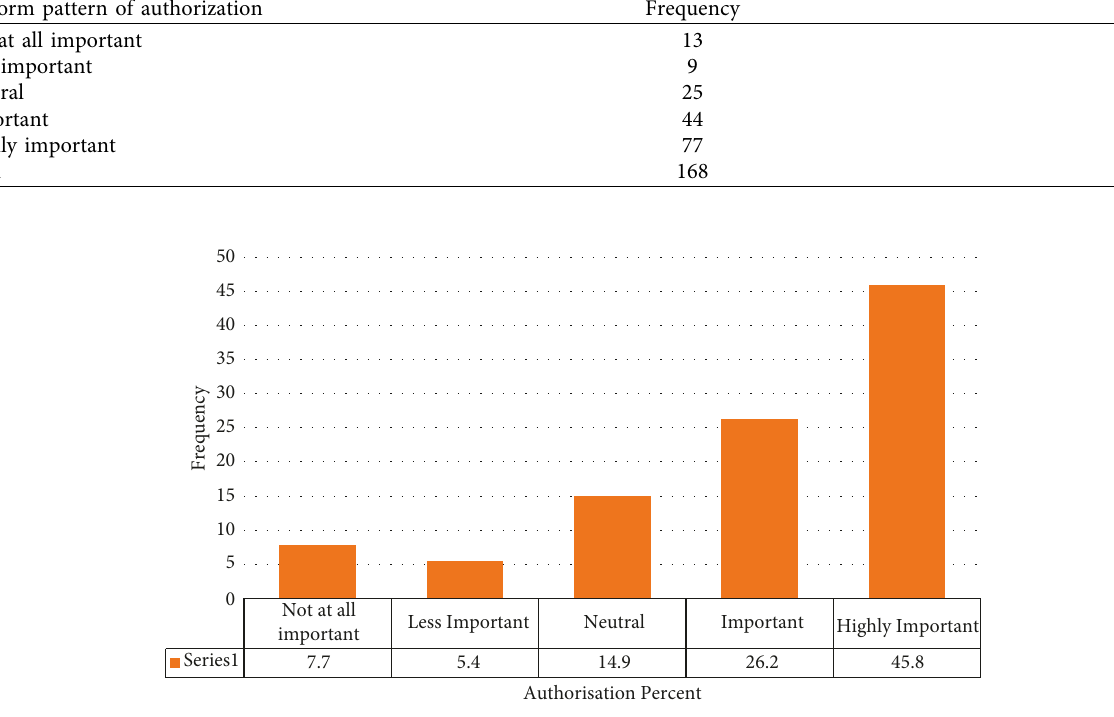
Figure 1: Uniform pattern of authorization. Table 2: Creating innovative solutions.